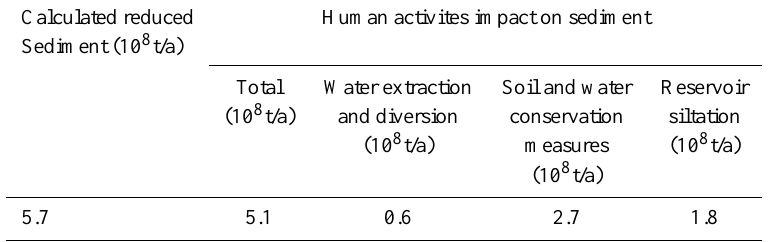
Table 11. The results of sediment reduction estimated in the MRYR